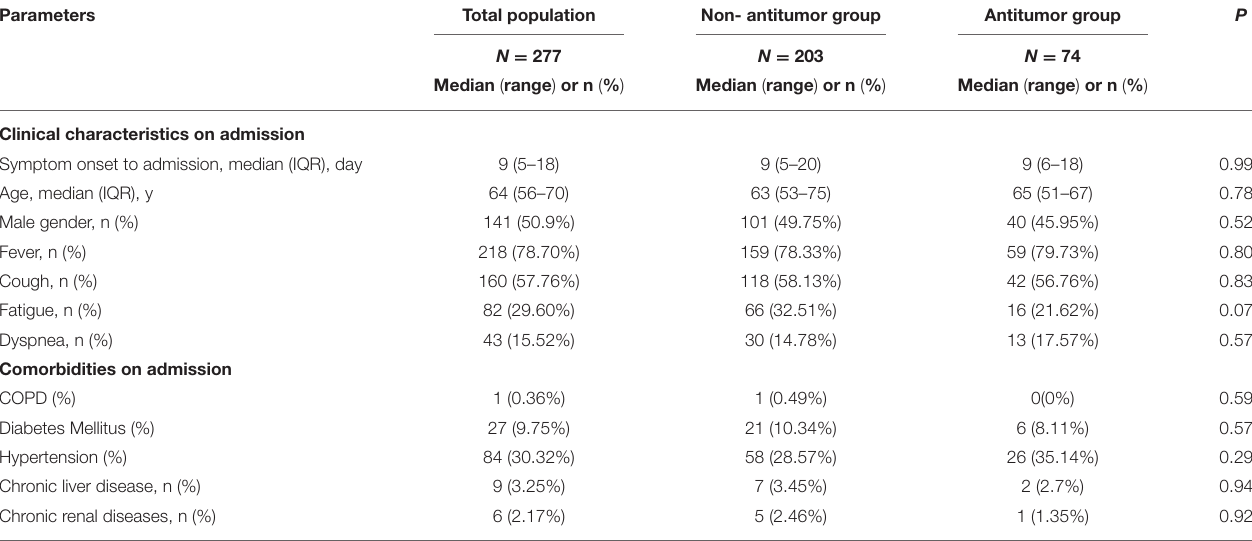
TABLE 3 | Clinical characteristics and Comorbidities of cancer patients with COVID-19 in Non-antitumor group and Antitumor group on admission. Parameters Total population Non- antitumor